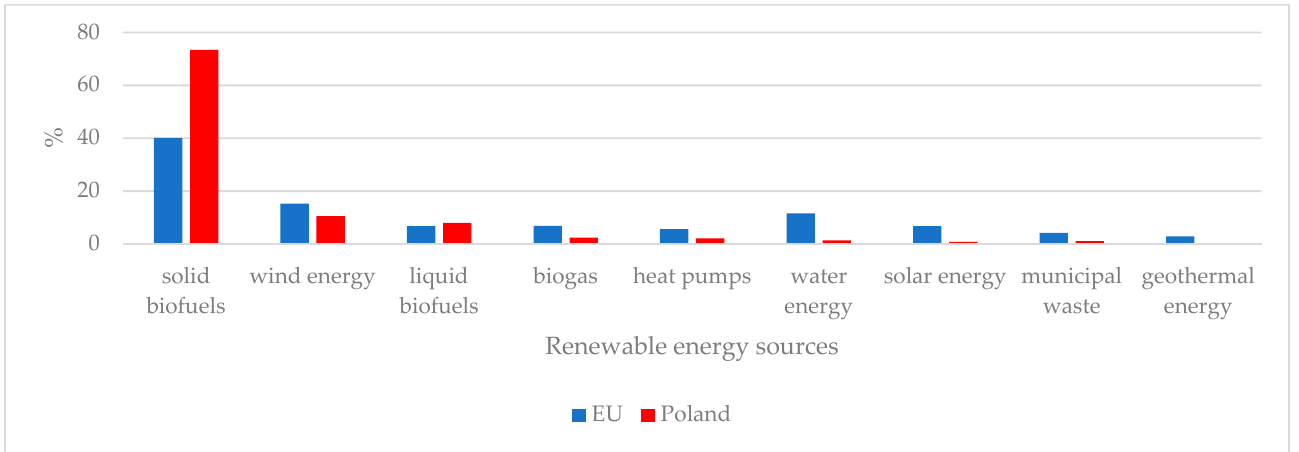
Figure 2. Obtaining energy from renewable sources in the EU-28 and Poland. Source: GUS—Energia ze ź róde ł odnawialnych w 2020 [55].